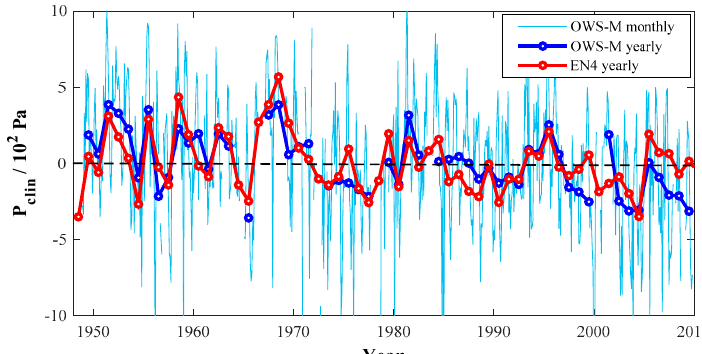
Figure 2. The P clin anomaly from OWS-M data and EN4 data. Note: The OWS-M station data are the daily profile observation results. Firstly, the monthly mean temperature and salinity values at different depths are obtained by averaging, and then the monthly mean P clin (at 840 m depth) is calculated from temperature and salinity; when the cumulative observation level of a month is less than 10 layers or the observation depth is less than 80 data 0 m, the month will be treated as a missing measurement. The annual mean P clin of the OWS-M station is obtained from the monthly data average. A year is regarded as a missing year if there are more than 4 months in the year of missing annual mean data and is not shown.